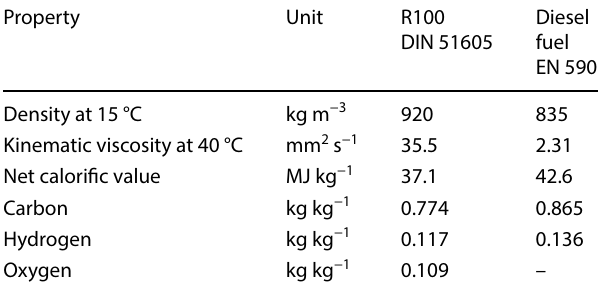
Table 3 Typical properties of pure rapeseed oil fuel (R100) and die- sel fuel [24]